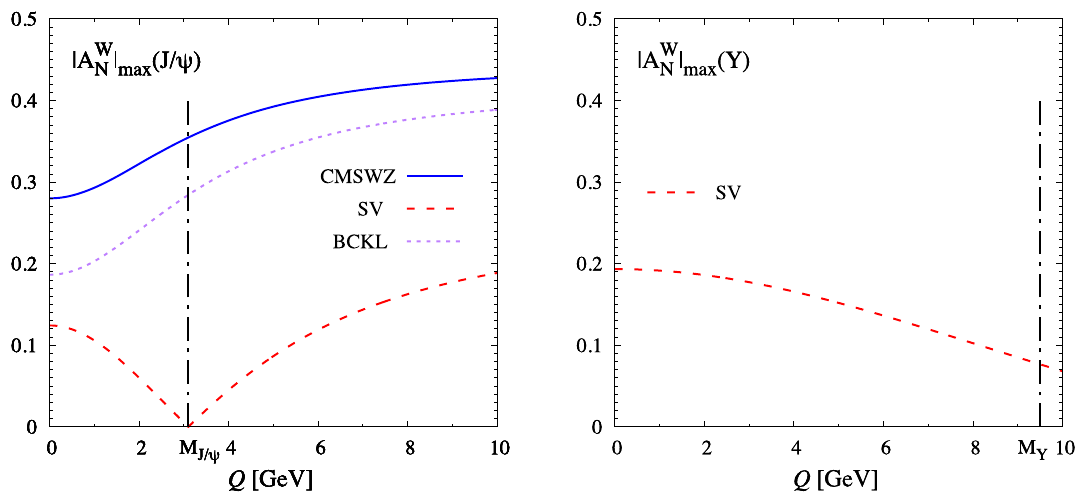
Fig. 6 Upper bounds for the (cid:2) cos2 φ T (cid:3) and A W asymmetries, with W = sin (φ S + φ T ), sin (φ S − 3 φ T ) , for e p → e (cid:5) J /ψ X (left panel) and N e p → e (cid:5) ϒ X (right panel), as a function of Q for y = 0 . 1. The labels CMSWZ, SV and BCKL denote the adopted LDME sets, given in Tables 1 and